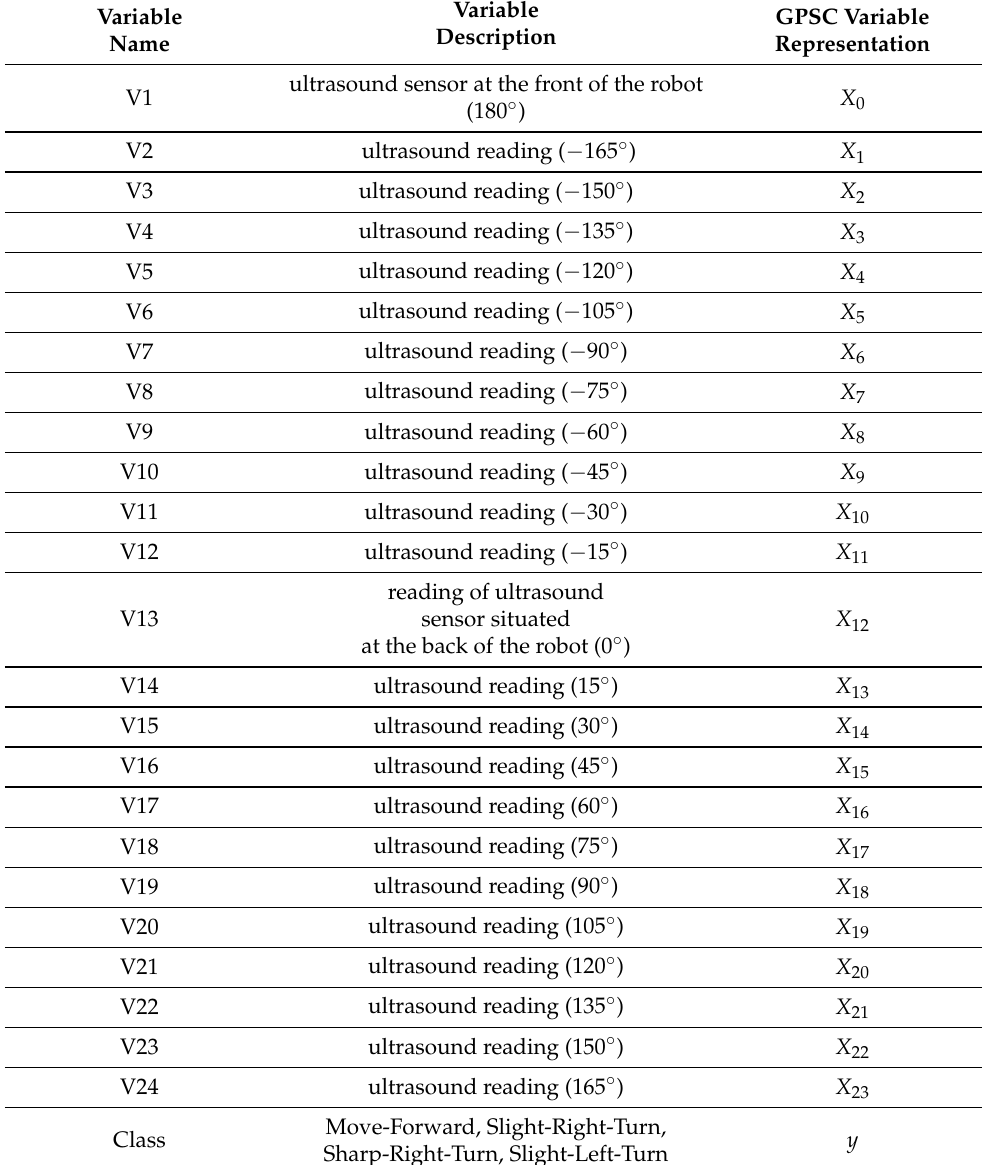
Table 2. The list of dataset variables, description of the variables, and the variable names used in the GPSC